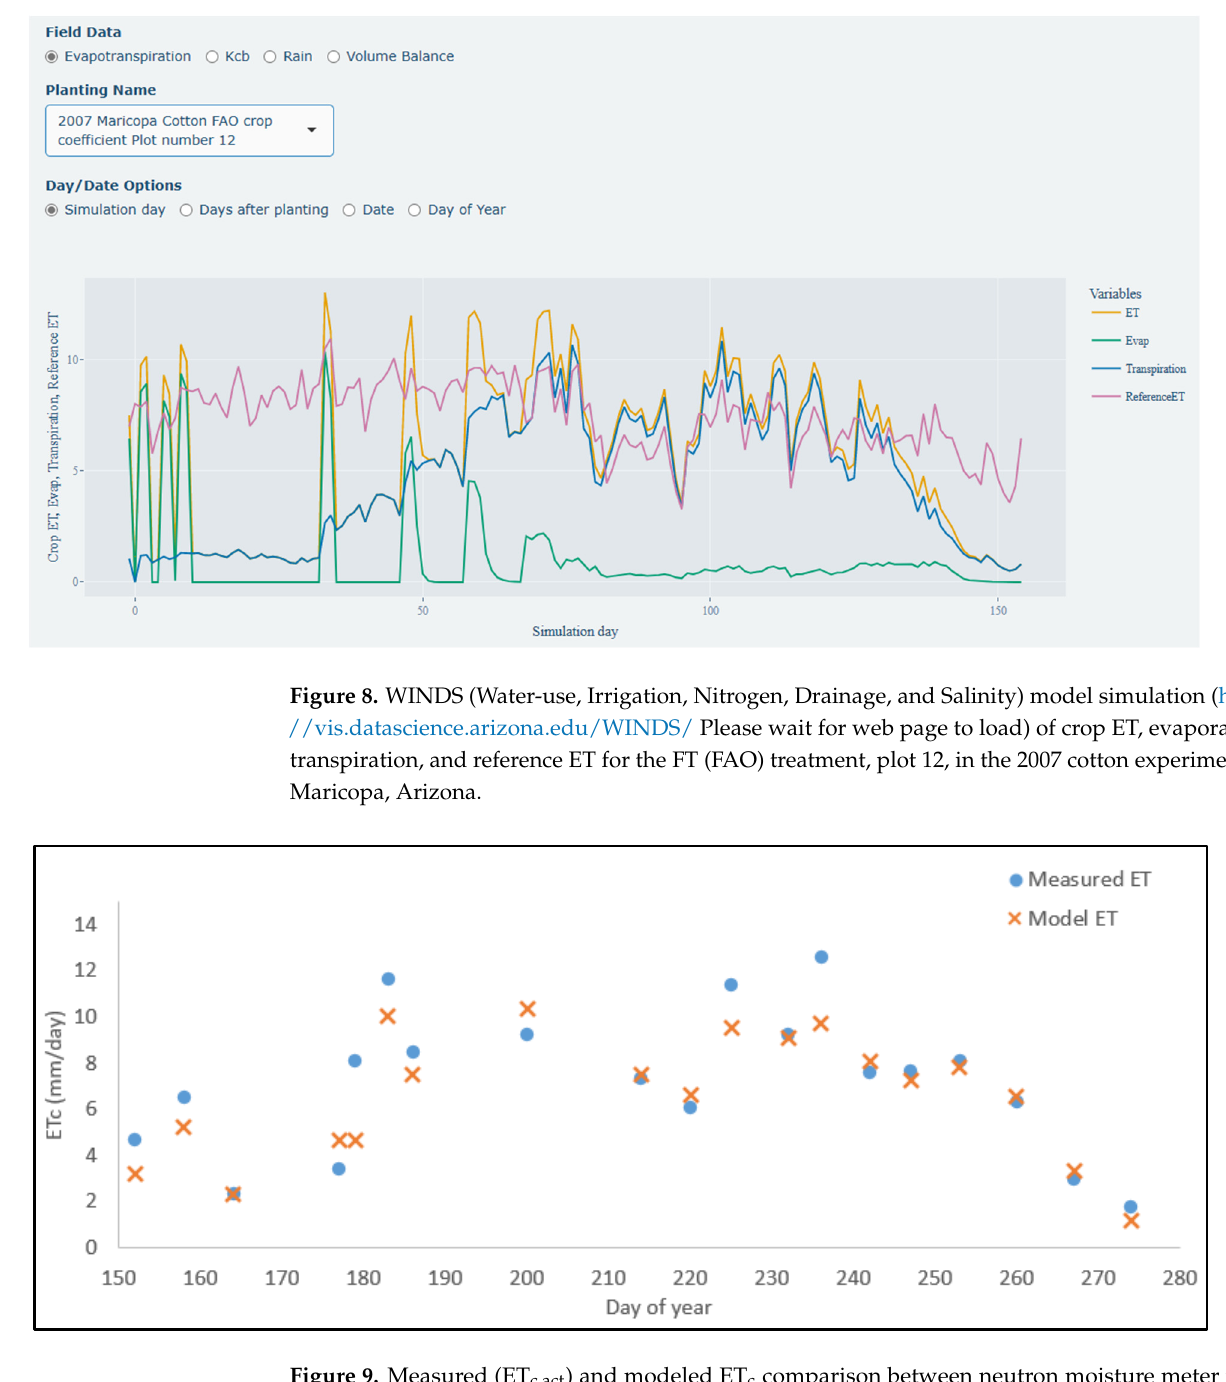
Figure 9. Measured (ET c act ) and modeled ET c comparison between neutron moisture meter measurement intervals for FT2 (FAO crop coe ffi cient curve) treatment.